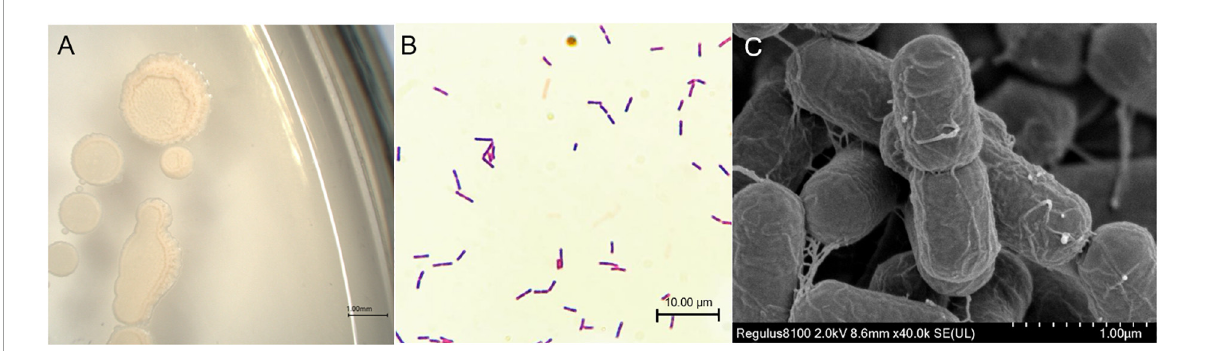
FIGURE1 Morphological identification of SYL-3. (A) Morphology observation of SYL-3 on LB agar medium. (B) Observation of the strain SYL-3 after Gram staining. (C) Scanning electron micrographs of the strain SYL-3.